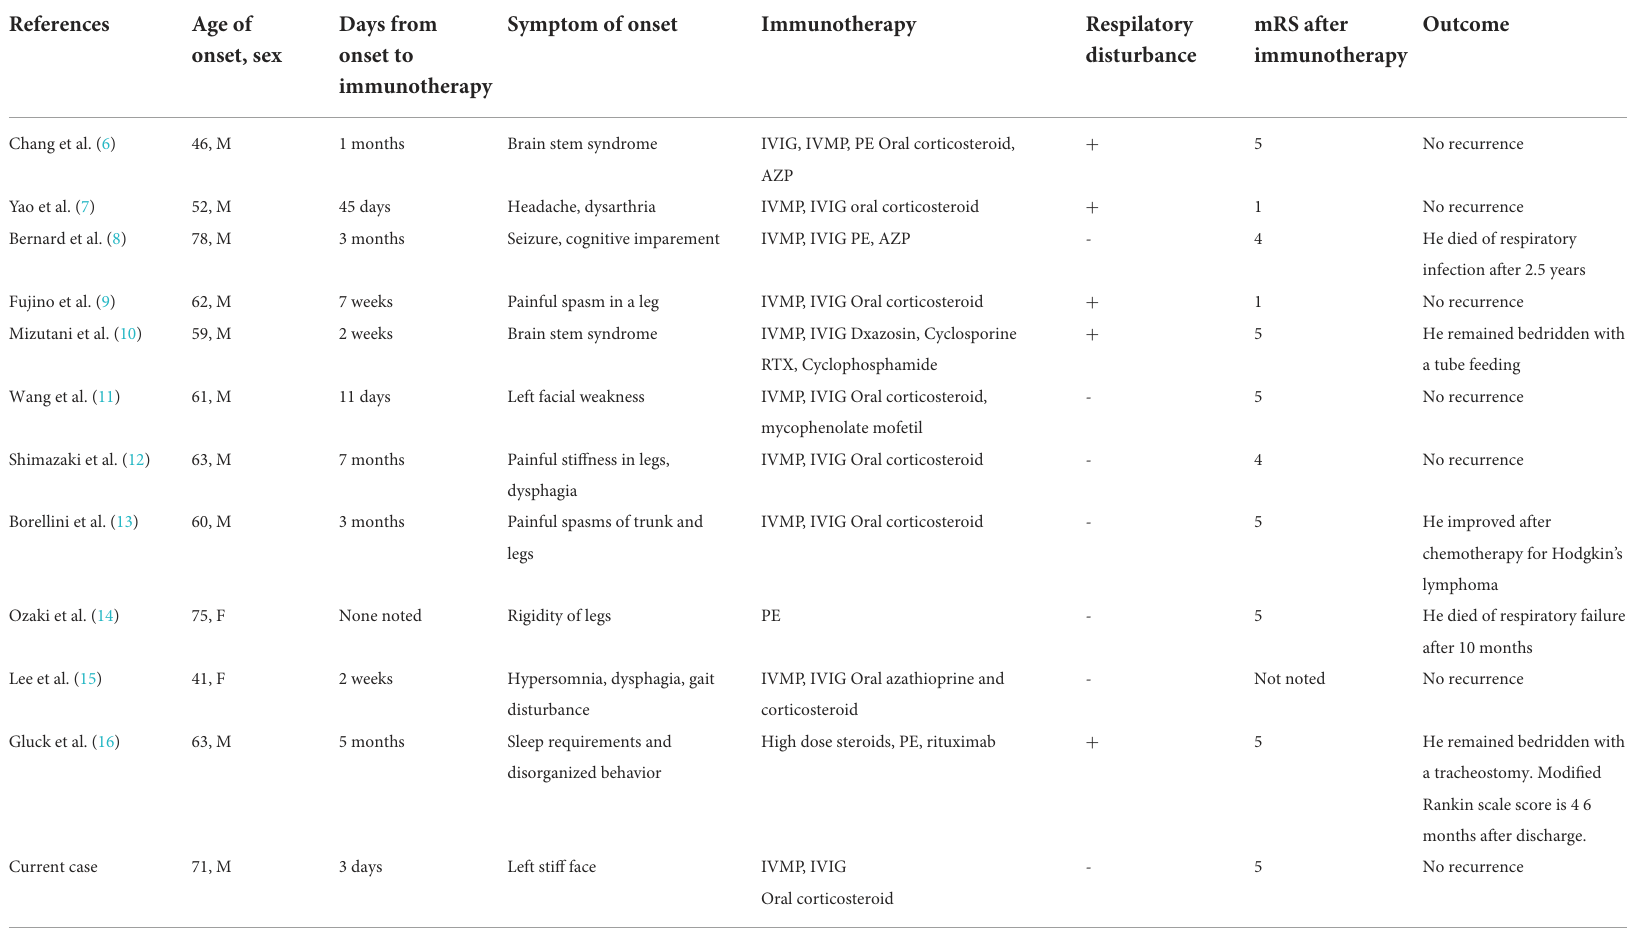
TABLE 1 A summary of published seropositive GlyR antibody positive PERM cases (including the current